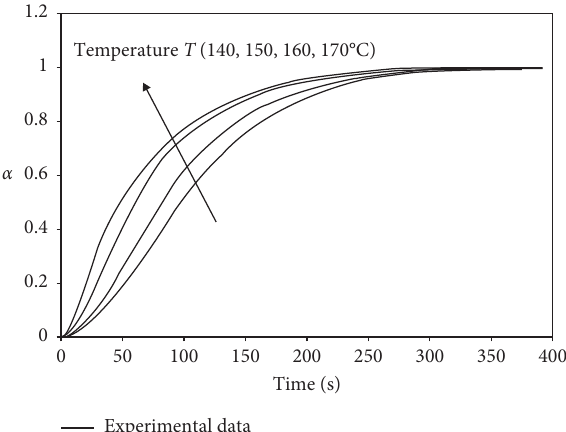
Figure 4: Cure kinetics curves: cure degree α as a function of time (s) evaluated at different temperatures (140, 150, 160, and 170 ° C).